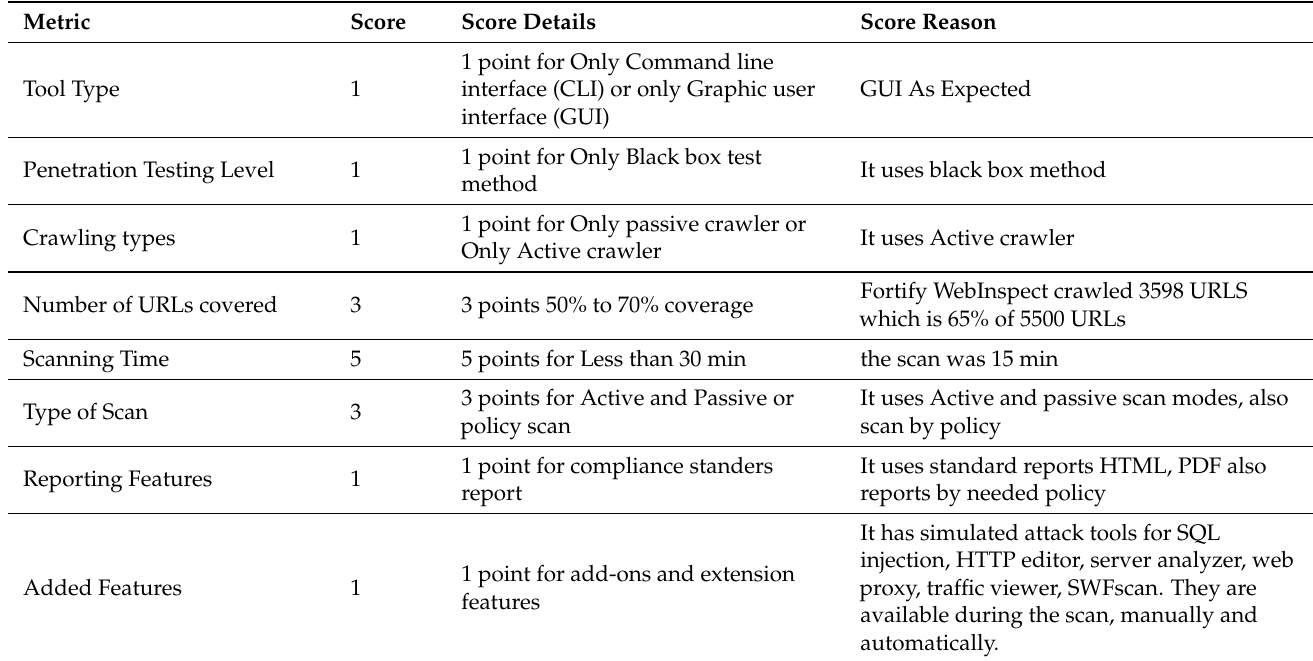
Table A4. Results of benchmarking Fortify WebInspect using our framework in